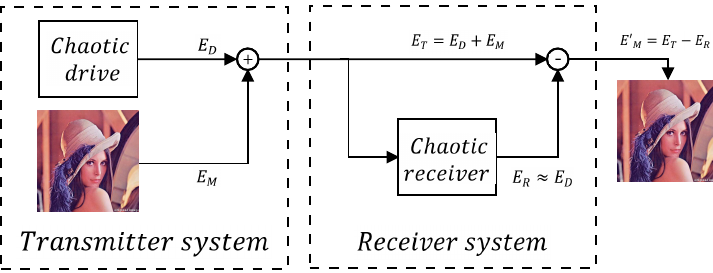
Figure 2. Encryption process adding chaos to an original image and recovering it through synchronizing two chaotic oscillators, as already shown in [20].